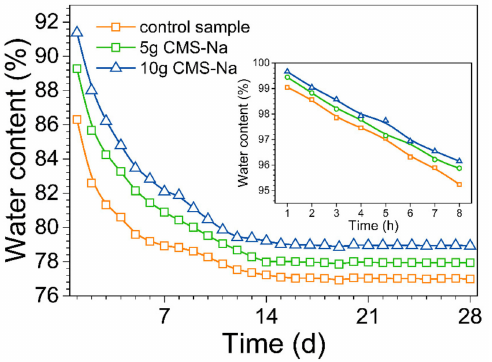
Figure 6. E ff ect of CMS on the water retention of AAM paste with curing time